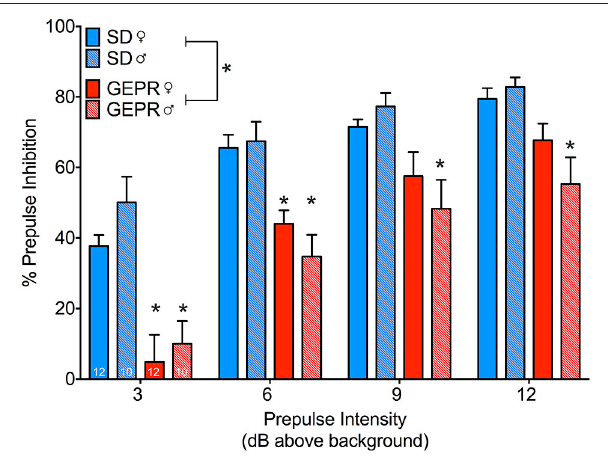
FIGURE 6 | Prepulse inhibition of the acoustic startle response. All groups showed the expected increase in inhibition as a function of increasing prepulse intensity [ F (2.3,93.1) = 82.2, P = 5 × 10 − 23 ], however GEPR-3s displayed a significant PPI deficit relative to SD rats [ F (1,40) = 43.5, P = 0.00000007]. Comparisons across strain for each sex revealed significant impairment in PPI at each prepulse intensity for male GEPR-3s as compared to male SD rats ( Ps < 0.002, Holm-Sidak adjusted). For female GEPR-3s as compared to female SD rats, this effect was evident at lower prepulse intensities (PP3: P = 0.005; PP6 P = 0.02), but not higher prepulse intensities (PP9 and PP12 Ps = 0.1). Figures show mean and standard error of the mean. *significantl difference between strain, stratified by sex and prepulse.